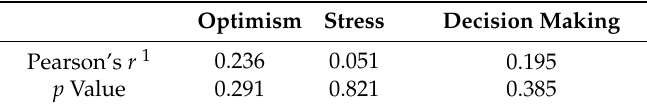
Table 3. Correlations between cortisol levels to psychological